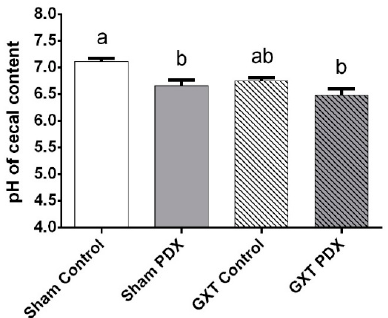
Figure 3. pH of cecal contents of animals of the experimental groups. Bars with same letters indicate no significant difference according to Tukey’s test ( p < 0.05). Different letters indicate a significant difference according to Tukey’s test ( p < 0.05). Sham Control: sham without polydextrose; Sham PDX: sham with polydextrose (7.5%); GXT Control: gastrectomized without polydextrose; GXT PDX: gastrectomized with polydextrose (7.5%). Values expressed as mean ± SEM.